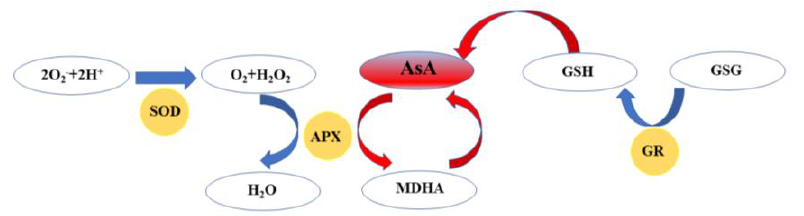
Figure 6. Mechanism diagram of AsA–GSH.